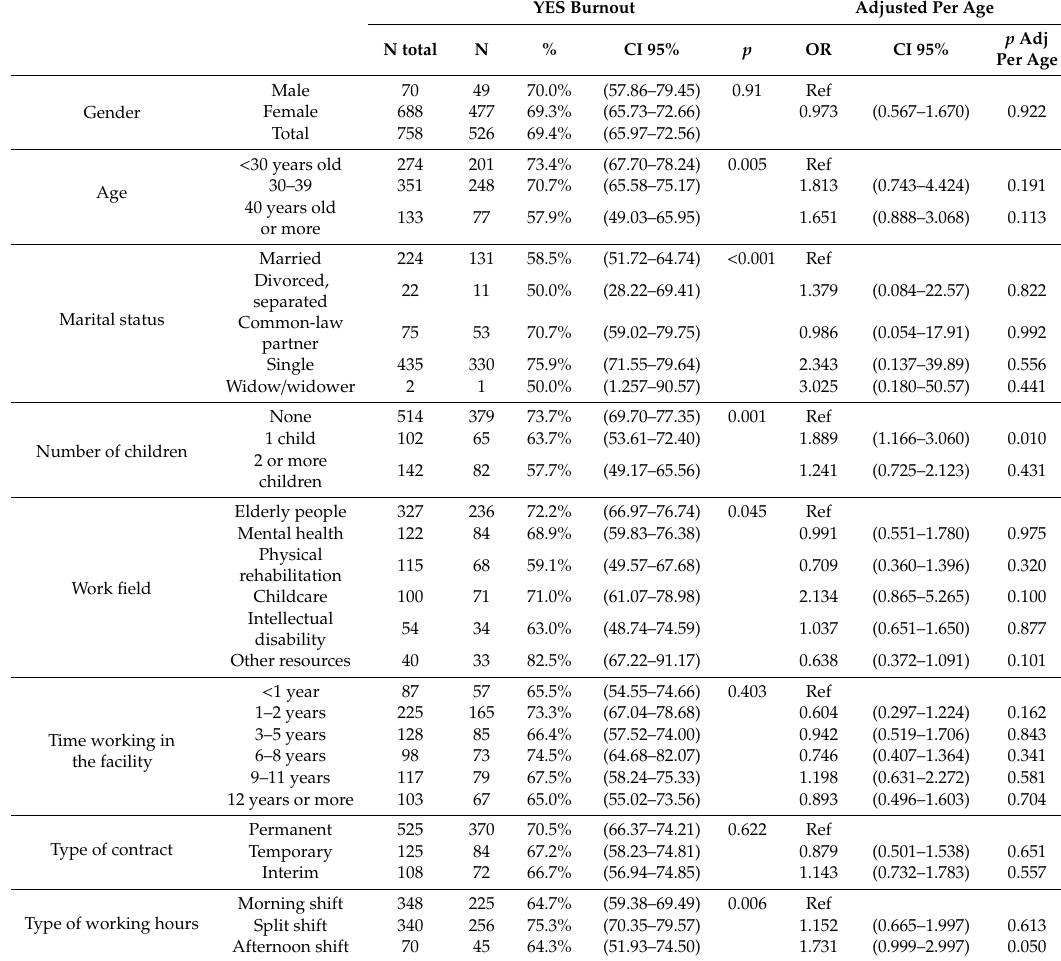
Table 3. Variables related to